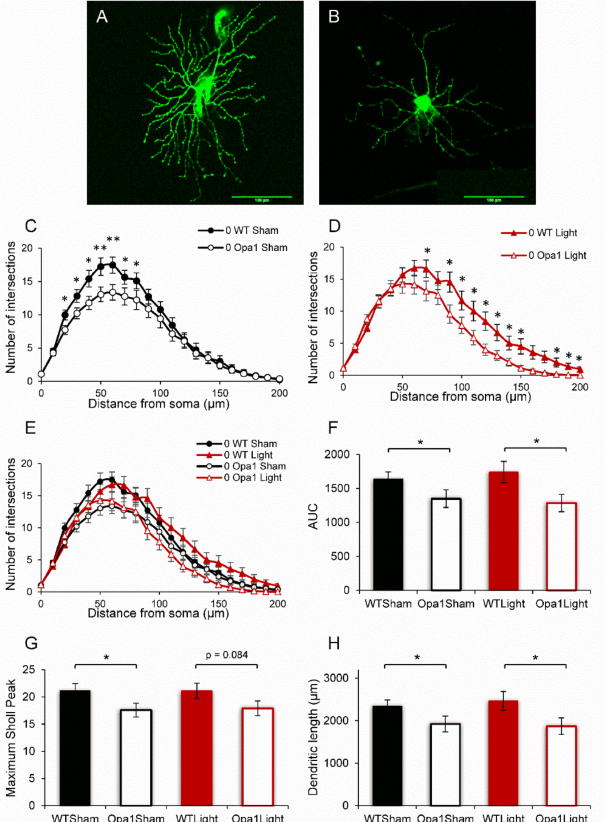
Figure 1. Aged Opa1 +/ − RGCs display degenerated dendritic complexity. Representative images of ( A ) a DiOlistically stained healthy WT RGC and ( B ) one that has undergone dendropathy. Scale bar measures 100 µ m. ( C , D ) Sholl profiles of both sham- and light-treated aged Opa1 +/ − RGCs revealed significant degeneration compared to age-matched WT cells. ( E ) No effects of the light treatment were observed on either the WT or Opa1 +/ − baseline dendritic complexity. ( F ) The area under the curve (AUC) expresses dendritic complexity as a single number and was significantly decreased in Opa1 RGCs. Dendritic complexity was also quantified by the maximum peak of the Sholl curve ( G ) and the total dendritic length ( H ). Mann-Whitney U-test * p < 0.05, ** p < 0.01. WT Sham n = 19 cells from 10 mice; Opa1 Sham n = 27 cells, 11 mice; WT Light n = 21 cells, 10 mice; Opa1 Light n = 20 cells, 8